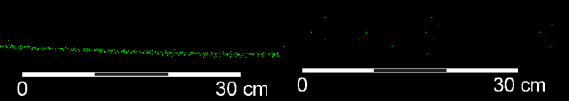
Figure 5. Cross-section for the same part of the road (Left: MLS, Right: UAV)